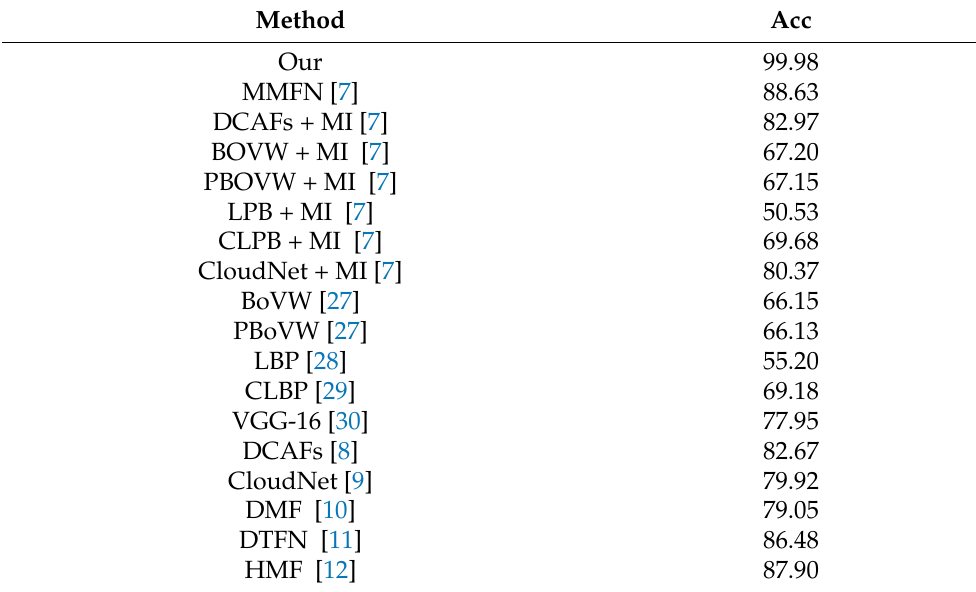
Table 6. Experimental results on MGCD dataset.